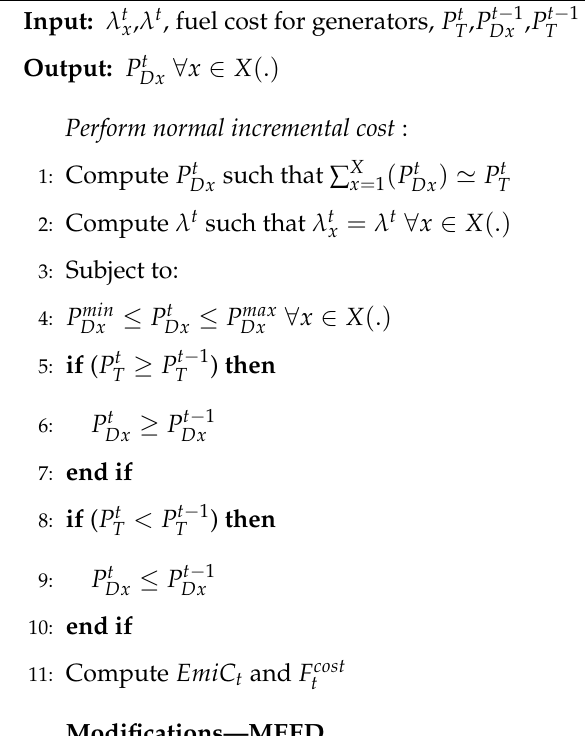
Algorithm 1: Modified incremental generator